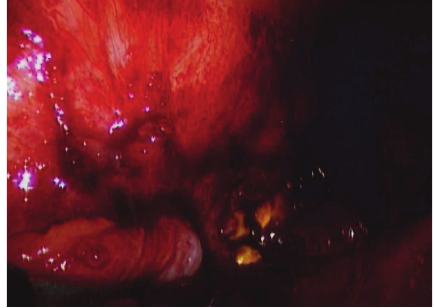
Figure 1: Stones in perihepatic